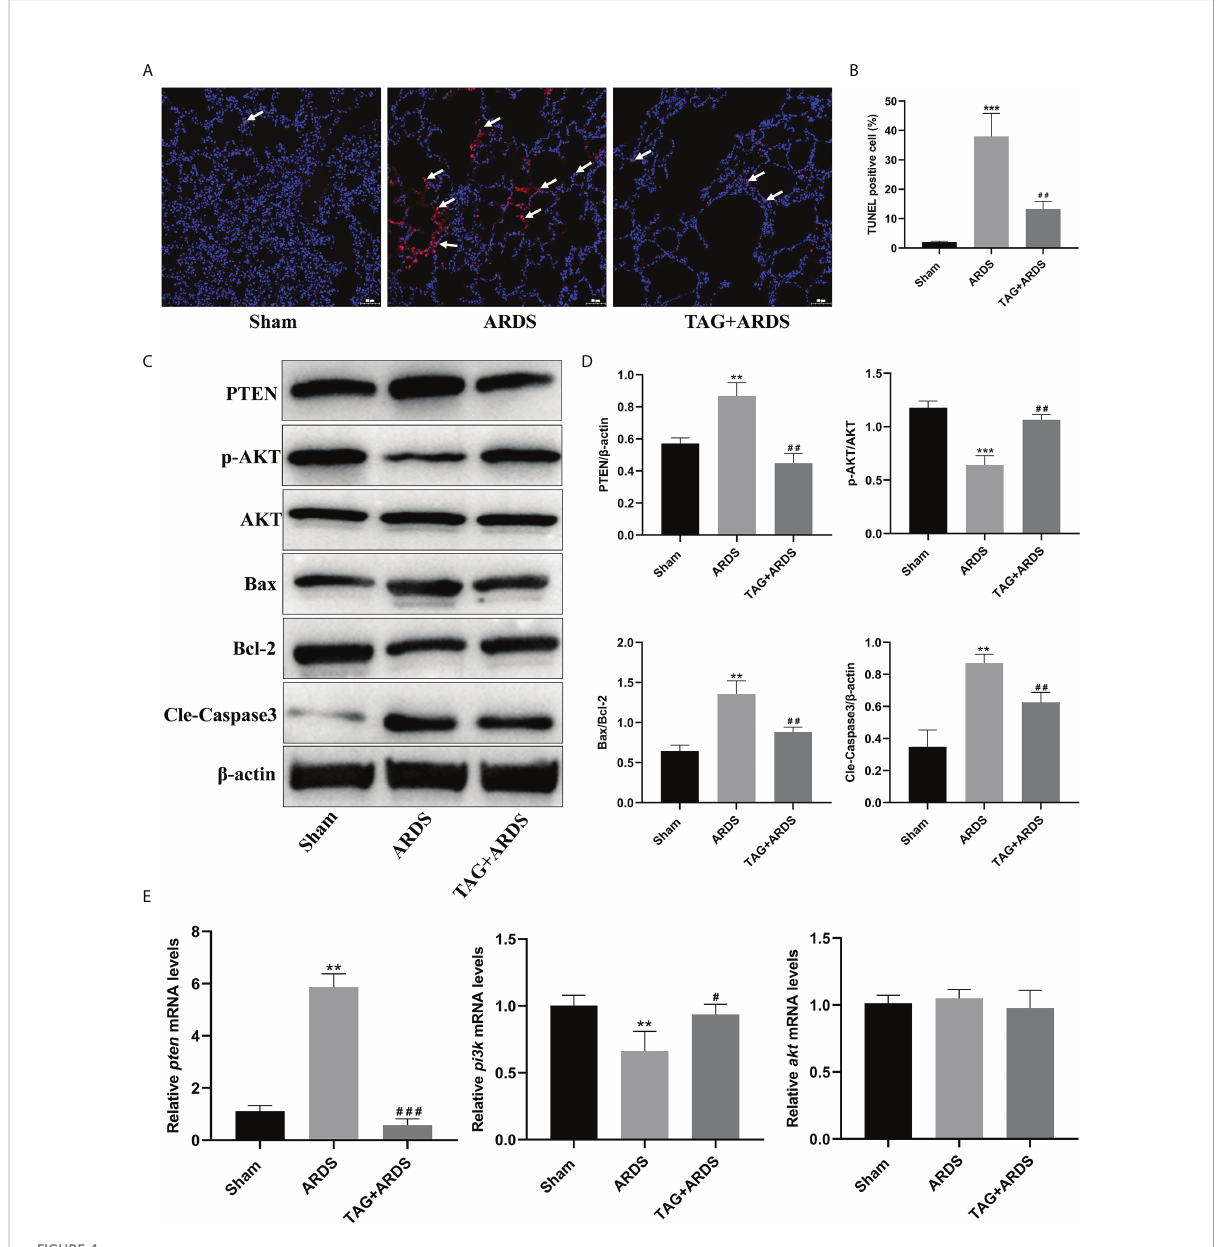
FIGURE 4 Effects of TAG on ARDS-induced apoptosis and PTEN/PI3K/AKT pathway. (A, B) Representative images of TUNEL-stained cells and their quantitation in lung tissue sections of 3 experimental animal groups: Sham, ARDS, and TAG + ARDS. Arrows represent apoptotic cells (scale bar = 50 m m). (C, D) Representative WB images and quantitation of PTEN, p-AKT/AKT, Bax/Bcl-2, and Cleaved Caspase 3 protein expression levels. (E) RT-qPCR results show that the transcripts levels for pten , pi3k , and akt mRNA. Data are presented as mean ± SD. p > 0.05, ** p < 0.01, *** p < 0.001, compared with the Sham group; p > 0.05, # p < 0.05, ## p < 0.01, ### p < 0.001, compared with the ARDS group. TAG, D-tagatose; ARDS, acute respiratory distress